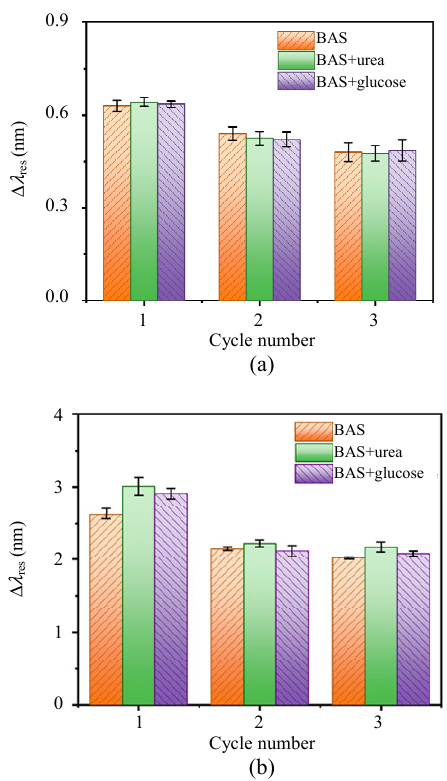
Fig. 6 Repeatabilities of the wavelength shift when measuring (a) the BSA analyte (0.4 mg/mL) and (b) BSA (2.0 mg/mL) during the three cycles,